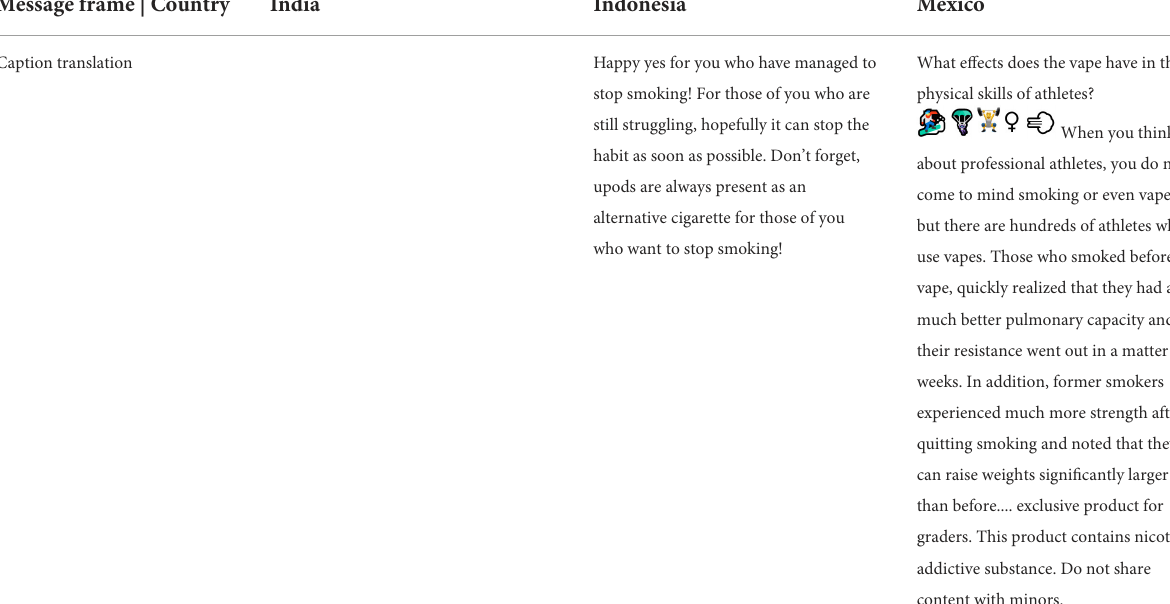
(Supplementary Figure 6A). In India, all e-cigarette marketing was observed on Instagram (100%). In Mexico, e-cigarette marketing was mostly observed on Facebook (56%), followed by Instagram (43%). In Indonesia, e-cigarette marketing was mostly observed on Facebook (51%), followed closely by Instagram